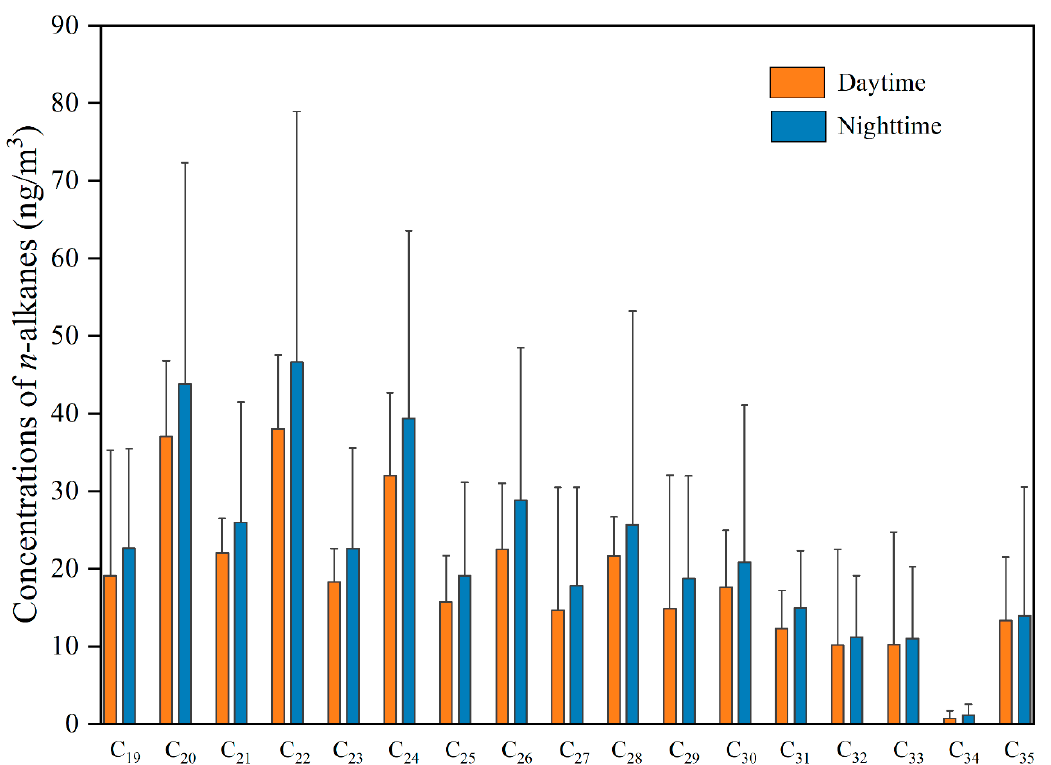
Figure 5. Average concentrations of 17 n − alkanes during the daytime and nighttime during the monitoring period. Error bar is one standard deviation of each individual n -alkane.